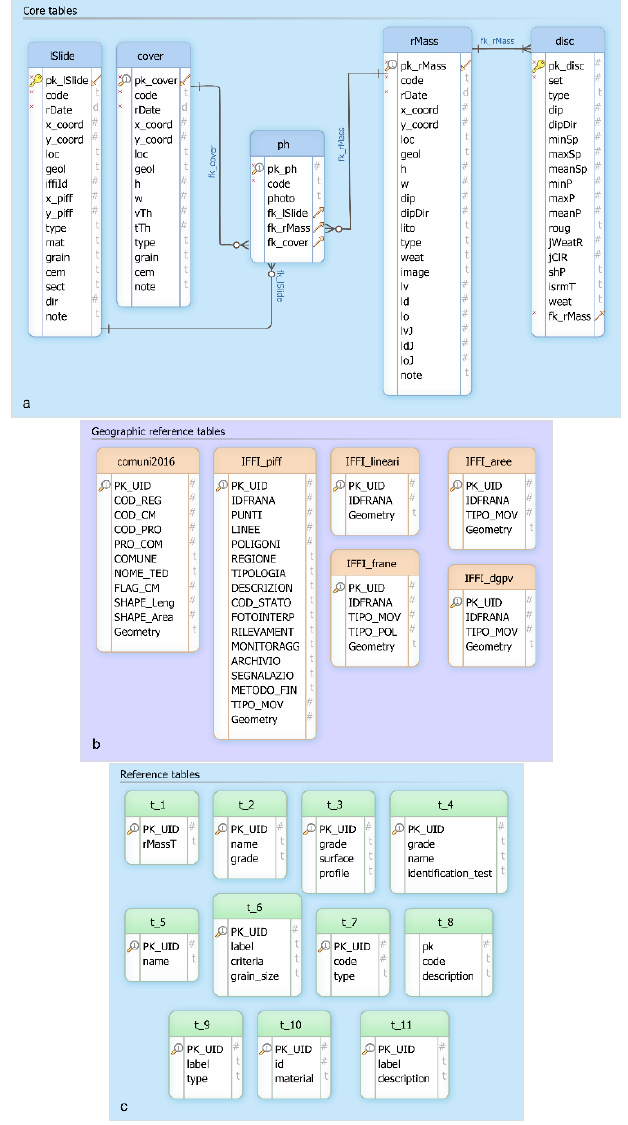
Figure 3. P arsifal database schema: ( a ) core tables; ( b ) reference geographic tables; ( c ) reference tables